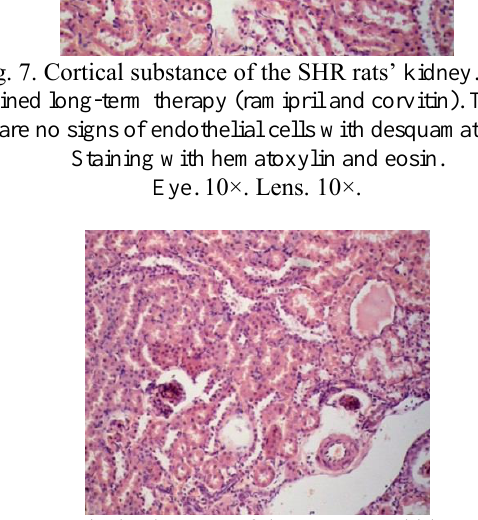
Fig. 8. Cortical substance of the SHR rats’ kidney. Com- bined long-term therapy (candesartan and corvitin). There is no atrophy of the renal glomeruli. Staining with hematoxylin and eosin. Eye. 10×. Lens. 10×.